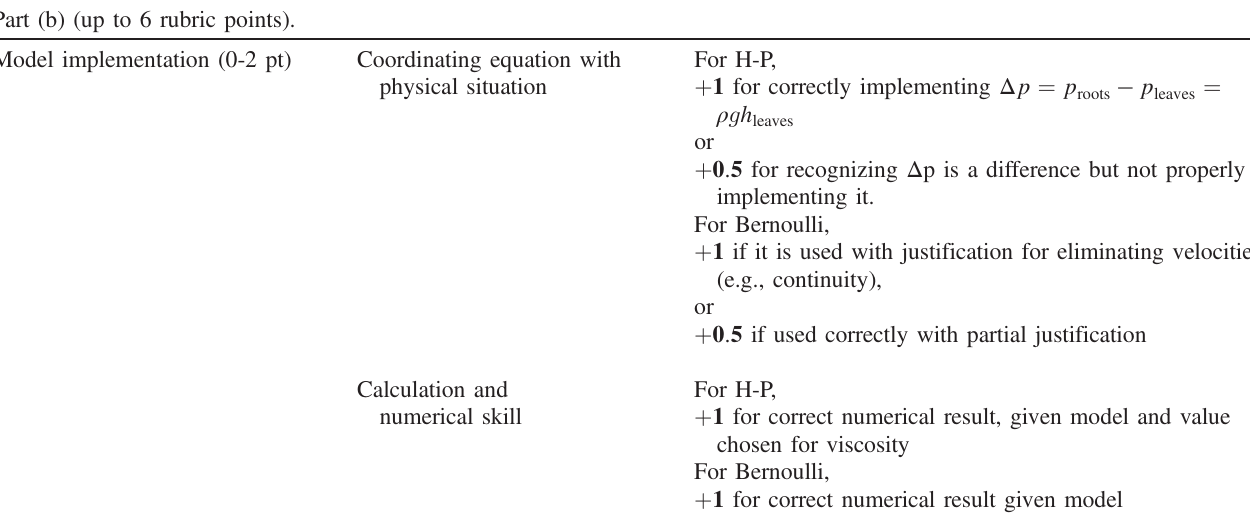
Part (b) (up to 6 rubric